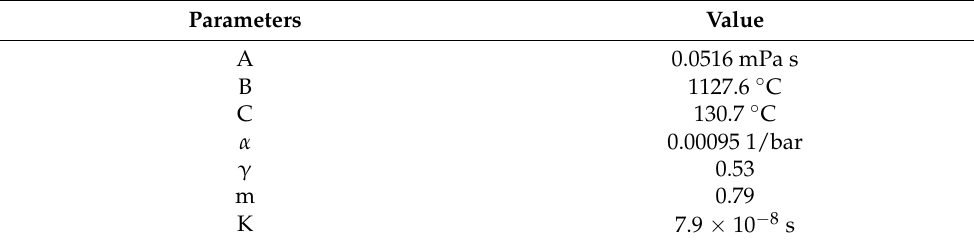
Table 6. Rheological parameters of